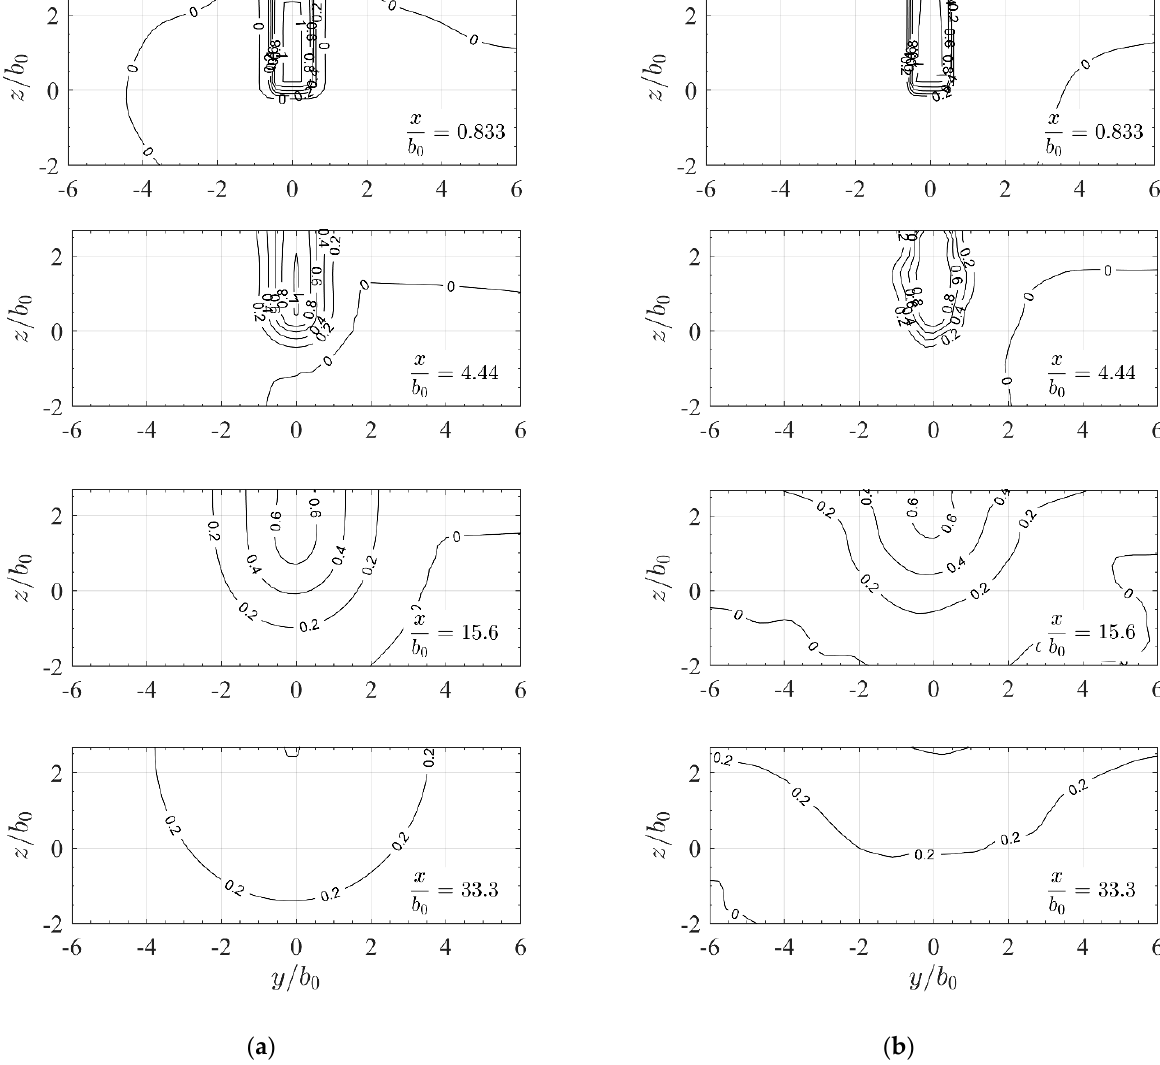
Figure 8. Channel jet showing isolines of the normalized streamwise velocity component u / u 0 in yz-sections with relative distances x / b 0 from the orifice as simulated for ( a ) ch-rans and ( b ) ch-des channel configuration. Distances y and z are normalized with channel/slot width b 0